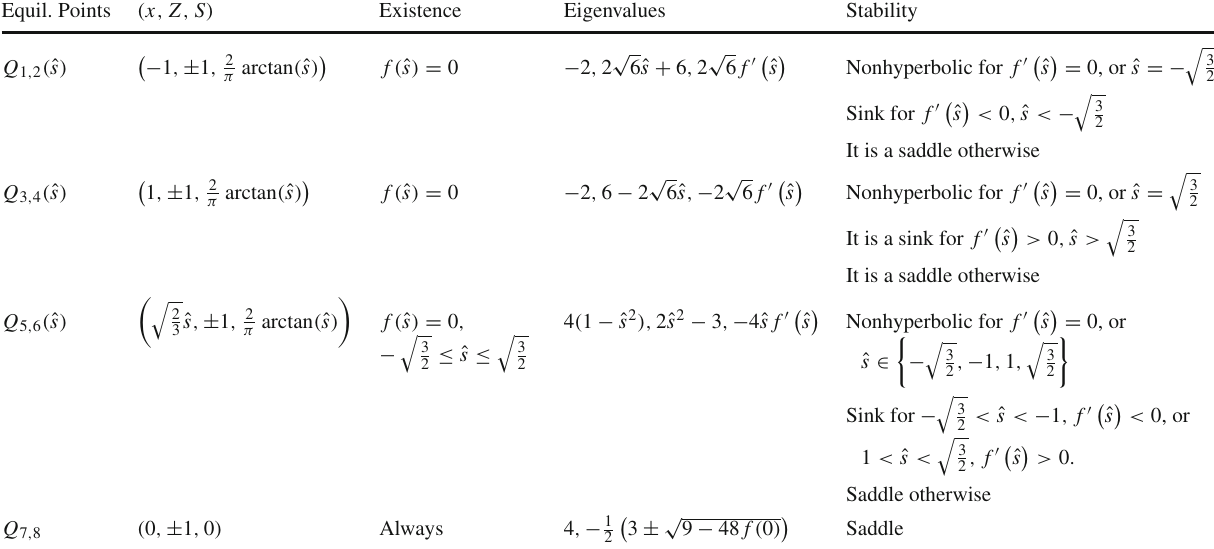
Table 2 Case 1: Equilibrium points at the infinity region of the system (21), (22), (23) Equil. Points ( x , Z , S ) Existence Eigenvalues